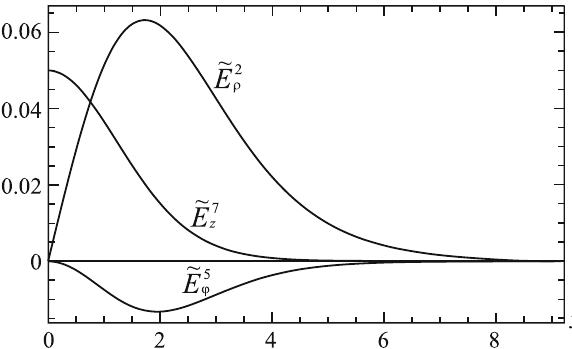
Fig. 3 Theprofilesofthecolorelectricfields ˜ E 2 ρ ≡ gE 2 ρ /φ 2 ( 0 ), ˜ E 5 ϕ